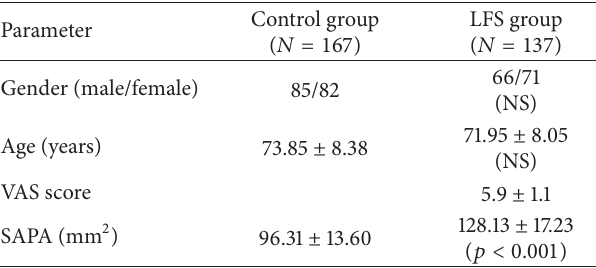
Table 1: Comparison of the characteristics of control and LFS